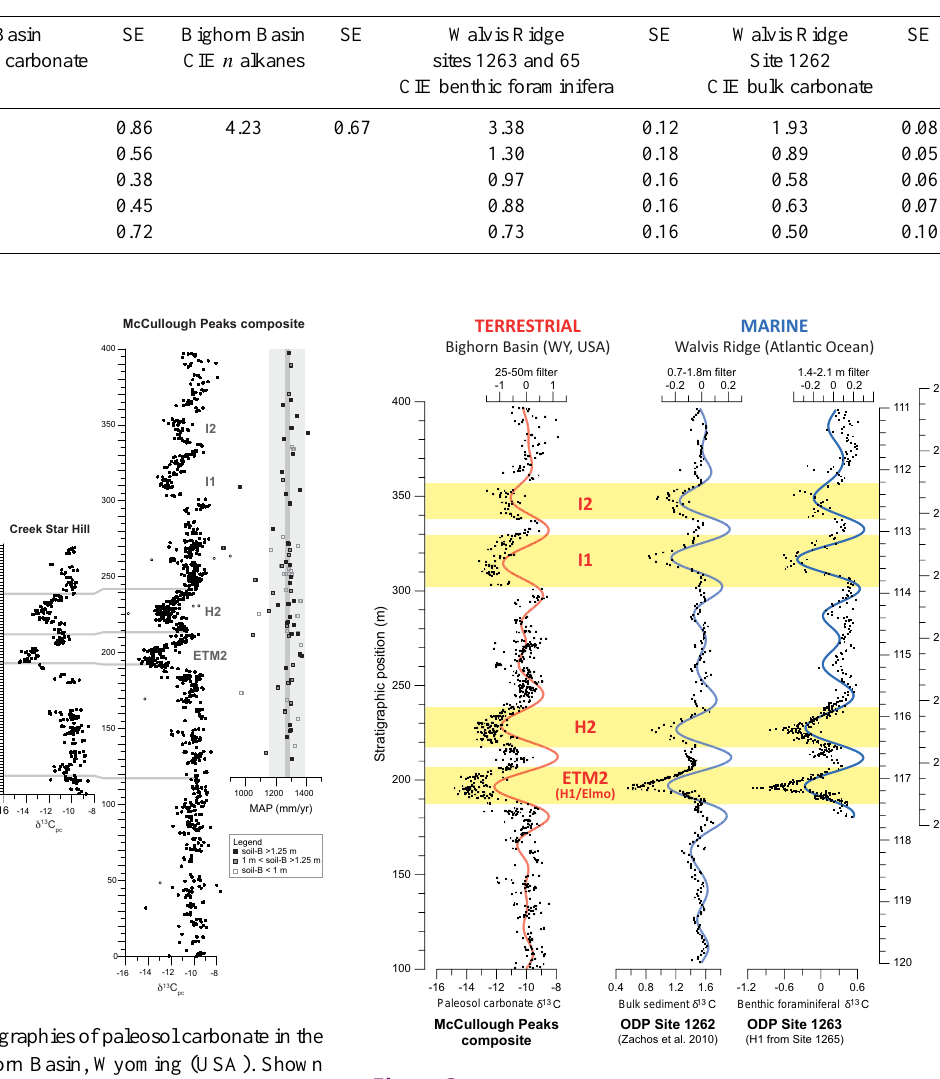
Table 1. Magnitudes of carbon isotope excursions for five Paleocene–Eocene hyperthermal events in paleosol carbonate of the Bighorn Basin, Wyoming (USA), and benthic foraminiferal and bulk sediment carbonate of Walvis Ridge sites 1263 and 1262, Atlantic Ocean. Standard errors (SEs) of the differences between detrended background variability and excursion variability are given (see the “Material and methods” section).